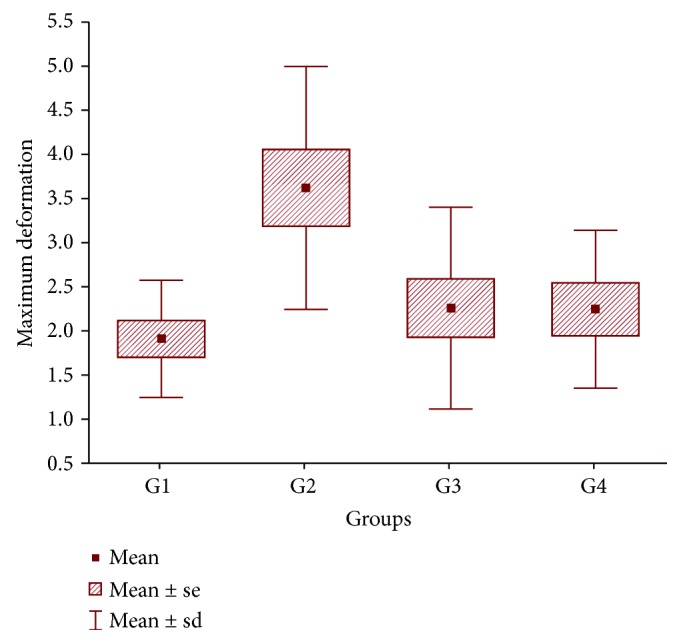
A histogram showing maximum deformation, which is significantly higher in the PRP group. G1 = SC; G2 = PRP; G3 = SC+PRP; G4 = ET. PRP: platelet-rich plasma; SC: stem cell: sd: standard deviation; se: standard error.